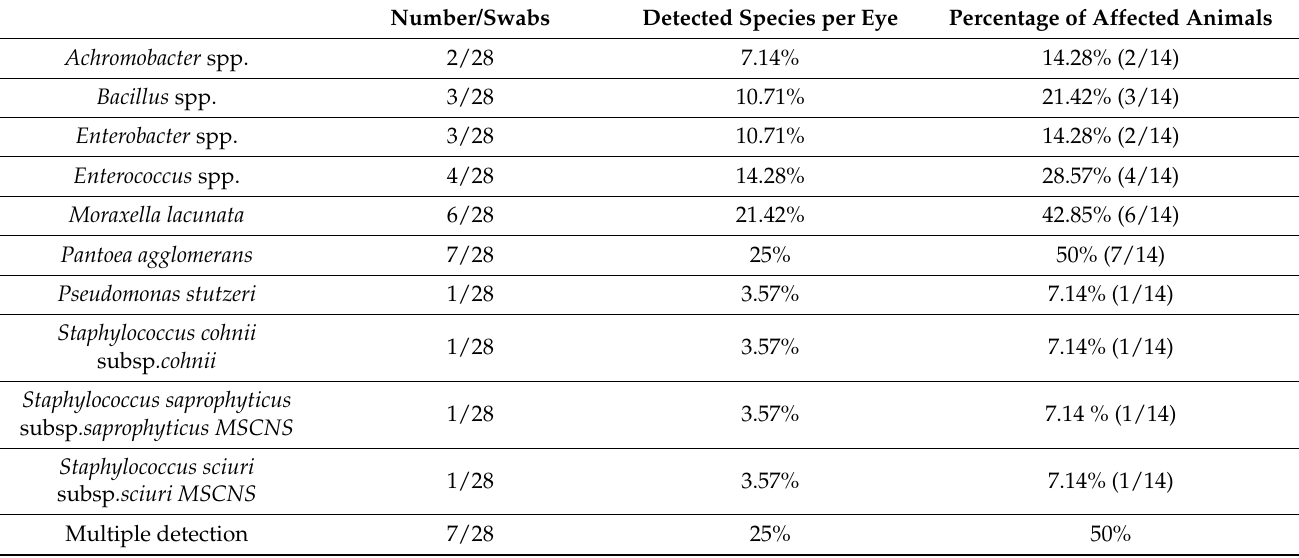
Table 1. The profile of detected bacterial species in healthy donkey’s